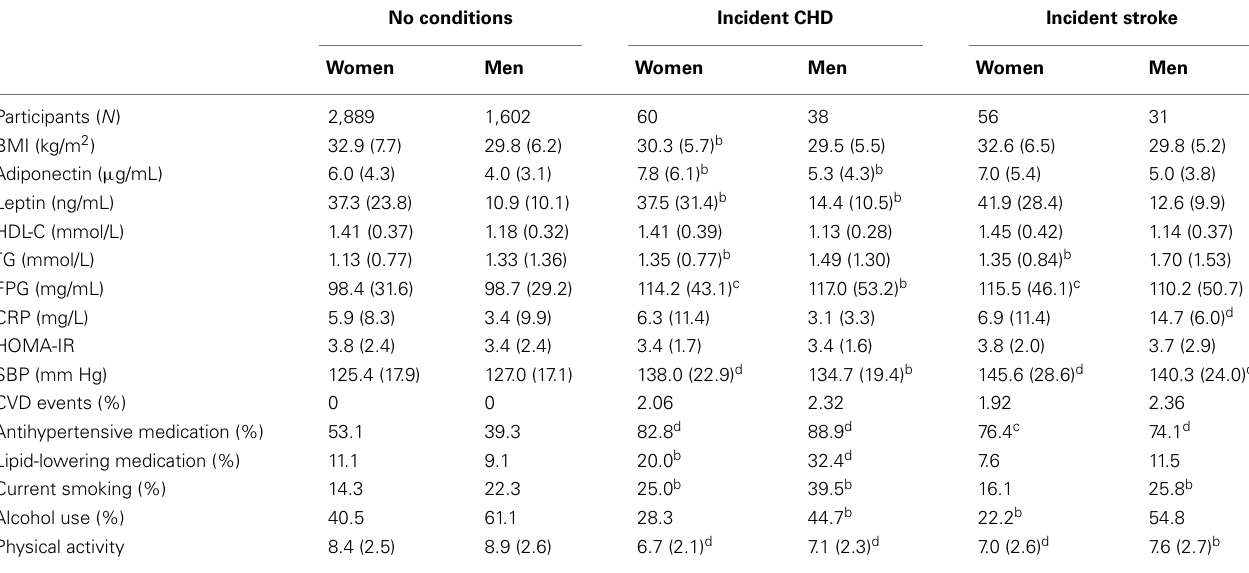
Table 1 | Sex-specific descriptive characteristics of the JHS participants with and without incident CHD/stroke events a . No